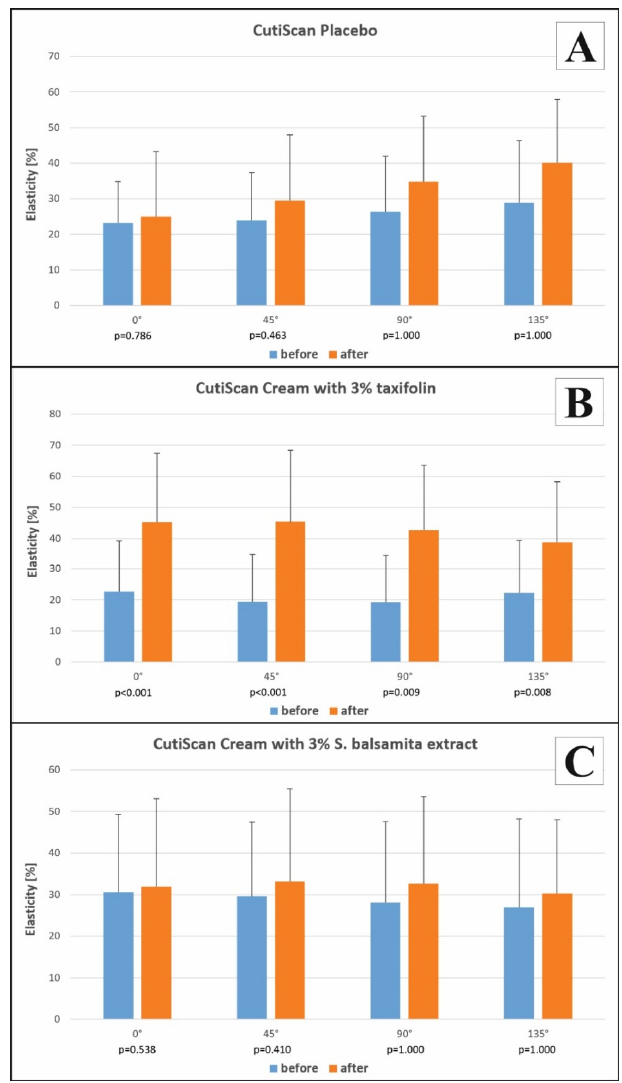
Figure 4. The comparison of skin viscoelasticity between the examined groups: placebo ( A ); cream with 3% taxifolin ( B ); cream with 3% S. balsamita extract ( C ). The results are expressed as mean ± standard deviation for angles 0°, 45°, 90°, and 135° before and after treatment. There was a significant difference between viscoelasticity measured before and after treatment for a cream with 3% taxifolin ( p < 0.05) ( B ). There was no significant difference between viscoelasticity measured before and after treatment for placebo and cream with 3% S. balsamita extract ( A , C ). The statistical analysis for comparison between placebo and examined groups was as follows: placebo versus 3% TXF cream p = 0.001 for 0°, p = 0.010 for 45°, p = 1 for 90°, p = 1 for 135°; placebo versus 3% S. balsamita cream p = 0.386 for 0°, p = 0.725 for 45°, p = 1 for 90°, p = 1 for 135°.